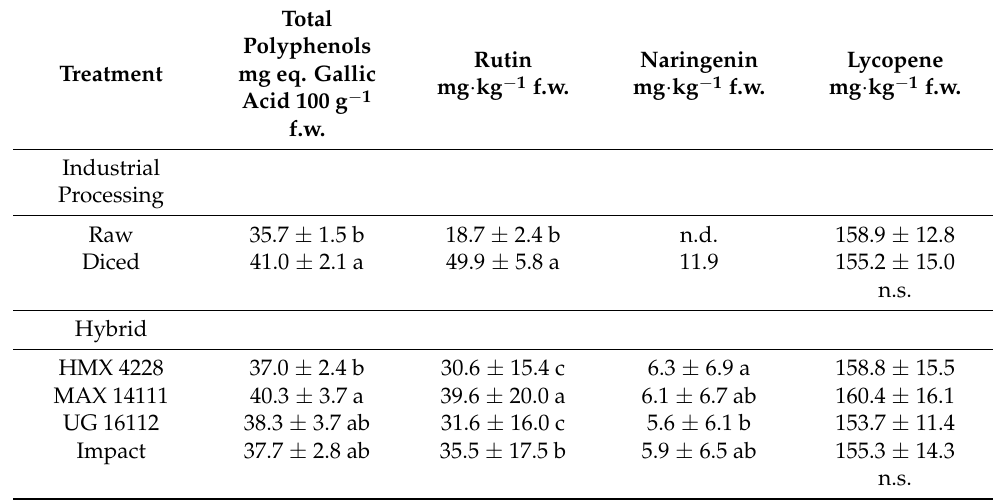
Table 6. Antioxidants concentration in tomato fruits as affected by industrial processing and hybrid. Total Treatment